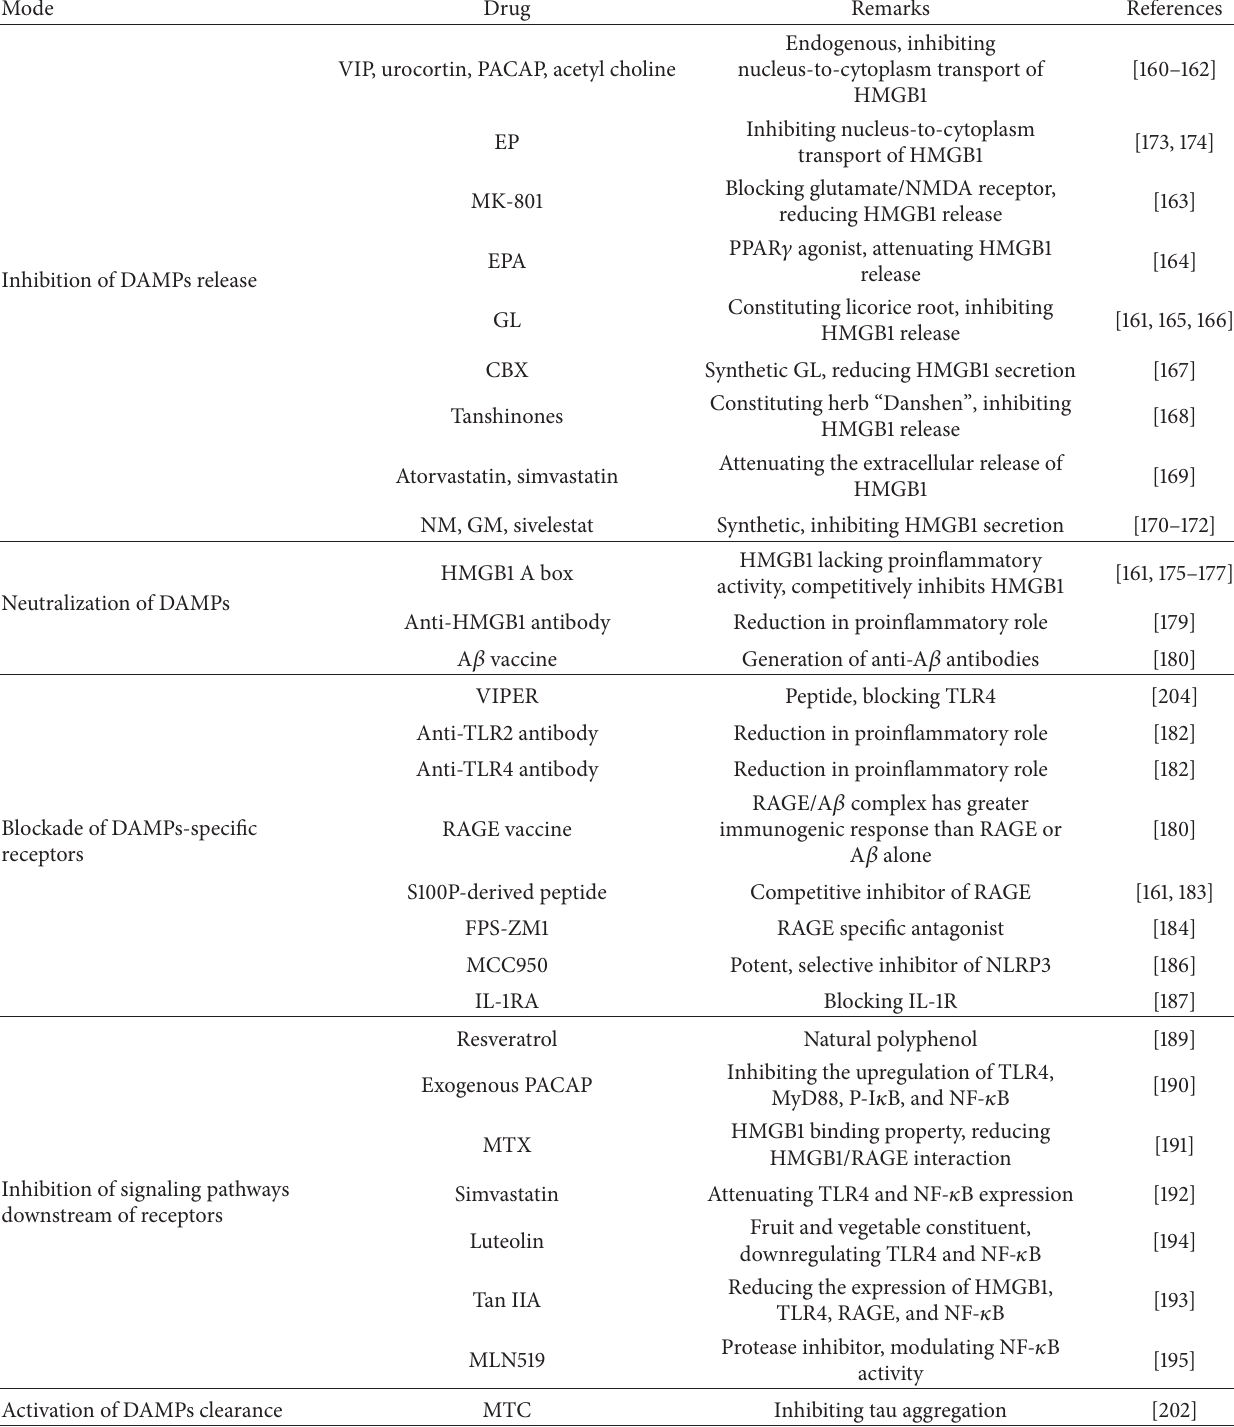
Table 2: A list of drugs that ameliorate DAMPs-induced